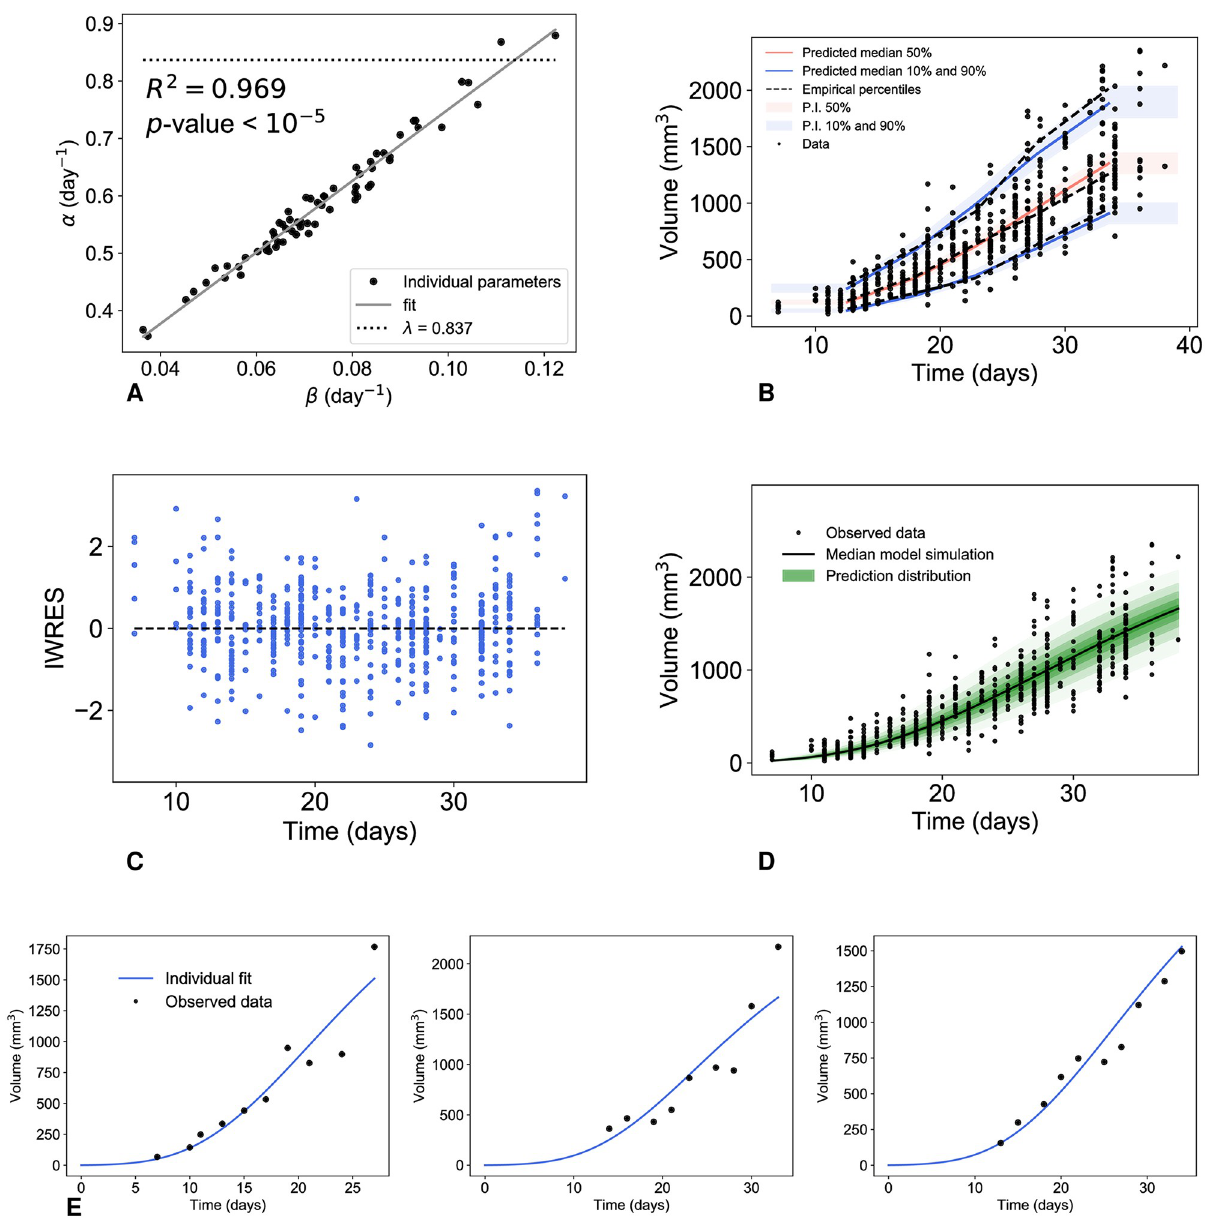
Fig 3. Correlation of the Gompertz parameters and diagnostic plots of the reduced Gompertz model from population analysis. Correlation between the individual parameters of the Gompertz model (A) and results of the population analysis of the reduced Gompertz model: visual predictive check (B), scatter plots of the residuals (C), prediction distribution (D) and examples of individual fits